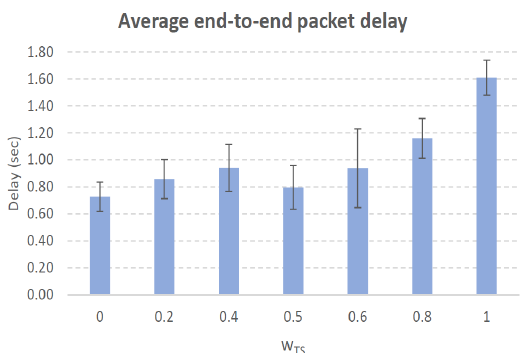
Figure 13. Average end-to-end packet delay. Scenario with high social media interaction (TS normal distribution with µ = 3 and σ = 1). Nodes’ density = 100 nodes/km 2 .